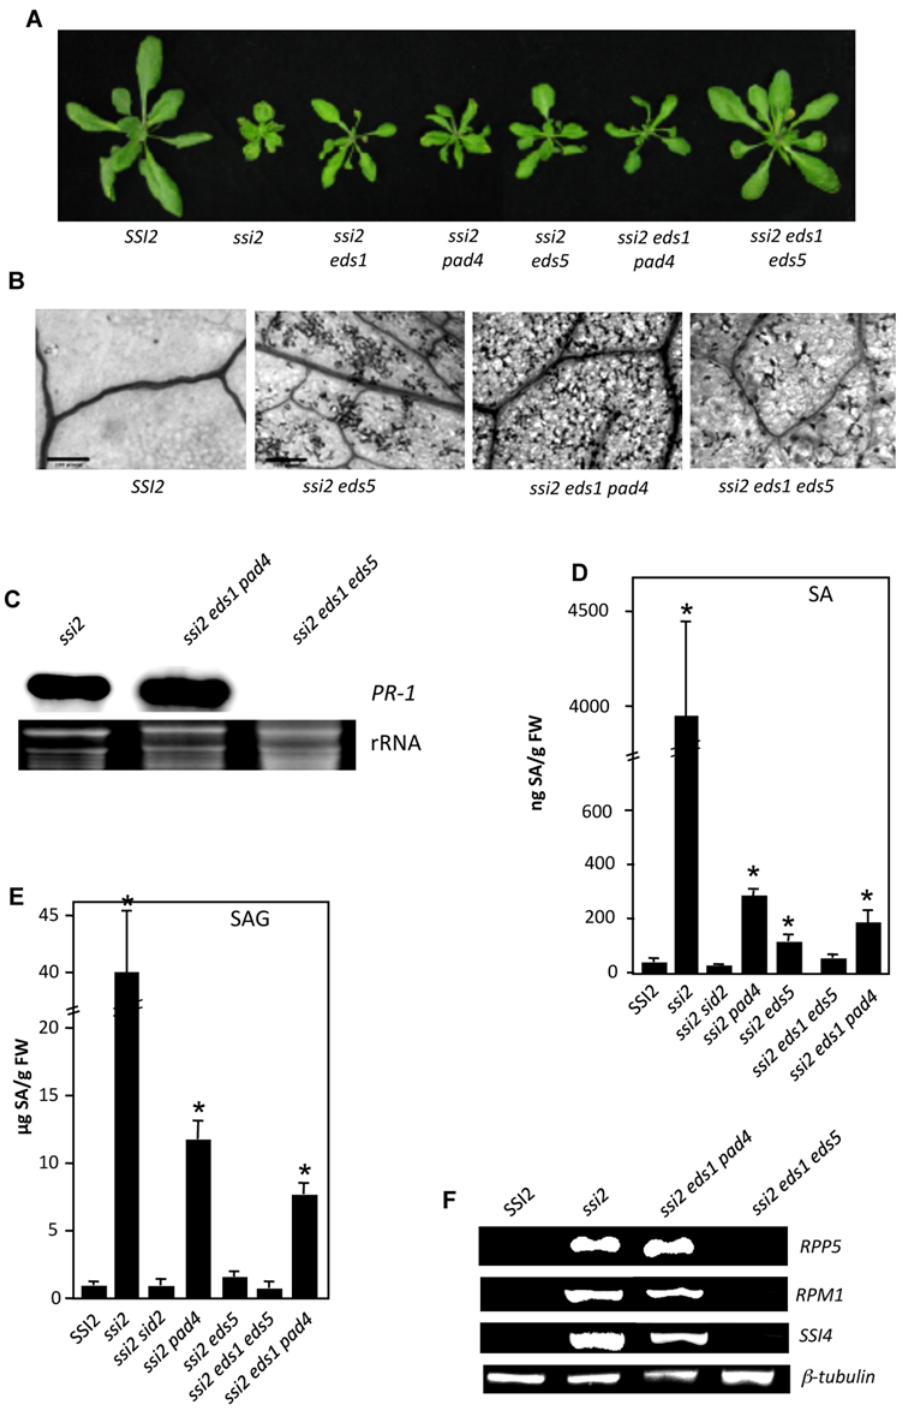
Figure 8. Morphology, cell death, SA/SAG levels. PR-1 and R gene expression ssi2 eds1-2 pad4-1 and ssi2 eds1-2 eds5-1 plants. (A) Comparison of the morphological phenotypes displayed by 4-week-old soil-grown wt ( SSI2 ), ssi2 , ssi2 eds1 , ssi2 pad4 , ssi2 eds5 , ssi2 eds1 pad4 , and ssi2 eds1 eds5 plants. (B) Microscopy of trypan blue-stained leaves from indicated genotypes. (C) Expression of PR-1 gene in indicated genotypes. Total RNA was extracted from 4-week-old plants and used for RNA gel-blot analysis. Ethidium bromide staining of rRNA was used as the loading control. (D) Endogenous SA levels in the leaves of 4-week-old soil-grown plants. Values are presented as mean of three replicates and the error bars represent SD. Statistical significance was determined using Students t -test. Asterisks indicate data statistically significant compared to SSI2 (Col-0) plants (P , 0.05, n=5). (E) Endogenous SAG levels in the leaves of 4-week-old soil-grown plants. Values are presented as mean of three replicates and the error bars represent SD. Asterisks indicate data statistically significant compared to SSI2 (Col-0) plants (P , 0.05, n=5). (F) RT–PCR analysis of R genes in indicated genotypes. The level of b -tubulin was used as an internal control to normalize the amount of cDNA template. The SSI2 EDS1 , SSI2 PAD4 , SSI2 EDS1 PAD4 , and SSI2 EDS1 EDS5 F2 plants showed wt–like morphology, accumulated basal levels of SA and showed basal level expression of PR-1 and R genes (data not shown).